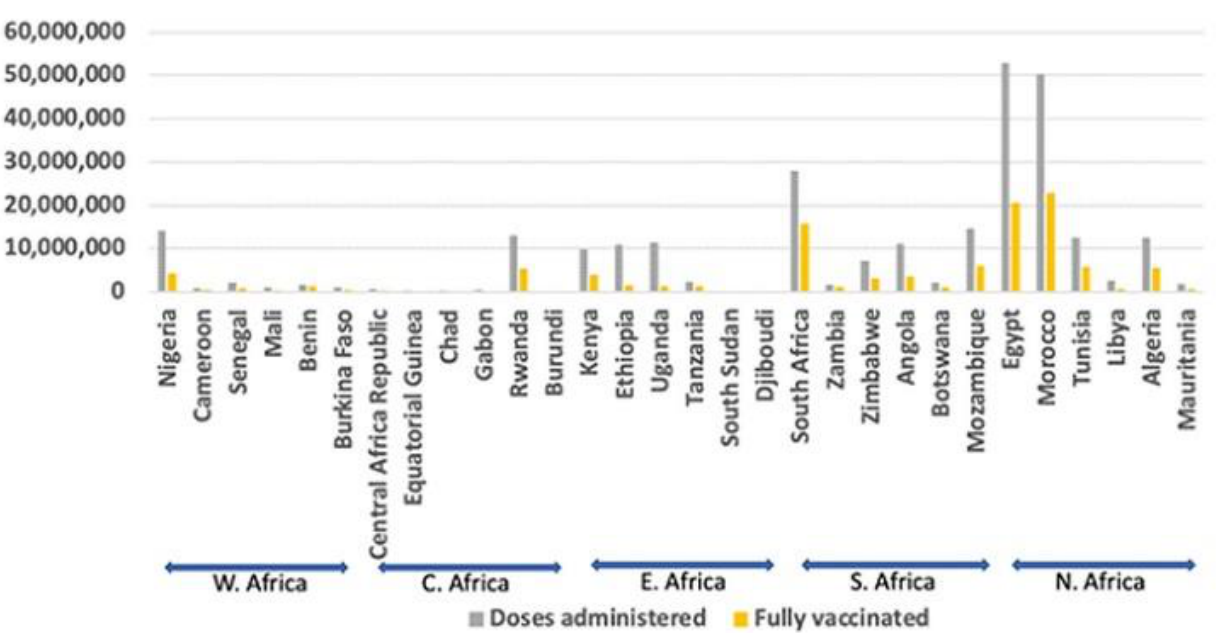
Figure 2 : A: Distribution of total doses administered and total number of fully vaccinated persons across the five regions. From left to right each group of six countries correspond to a region, West Africa, Central Africa, East Africa, Southern Africa, and North Africa,